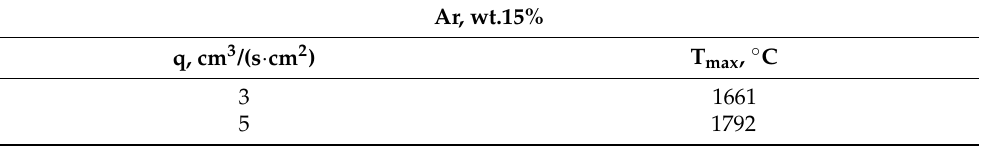
Table 4. Maximum combustion temperature of the (70% AlN + 30% Al) samples.